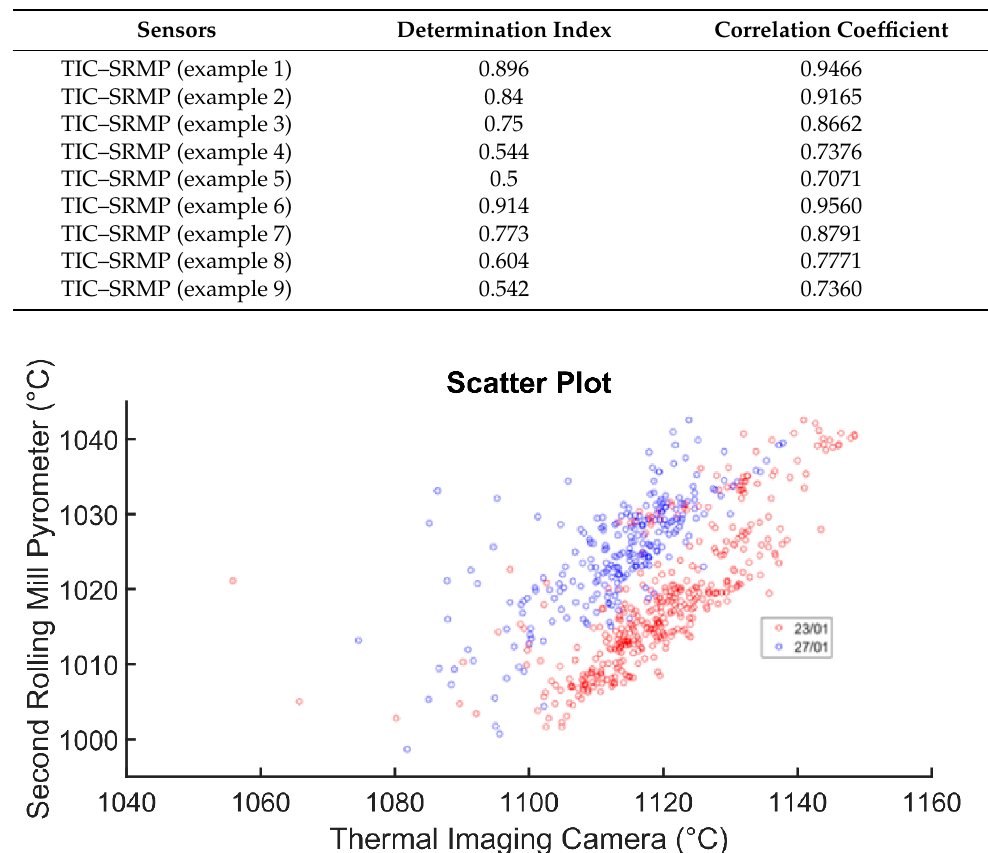
Table 6. Data analysis results ( modified plant configuration) for the billets of the same steel quality and of the same diameter for the related finished products.